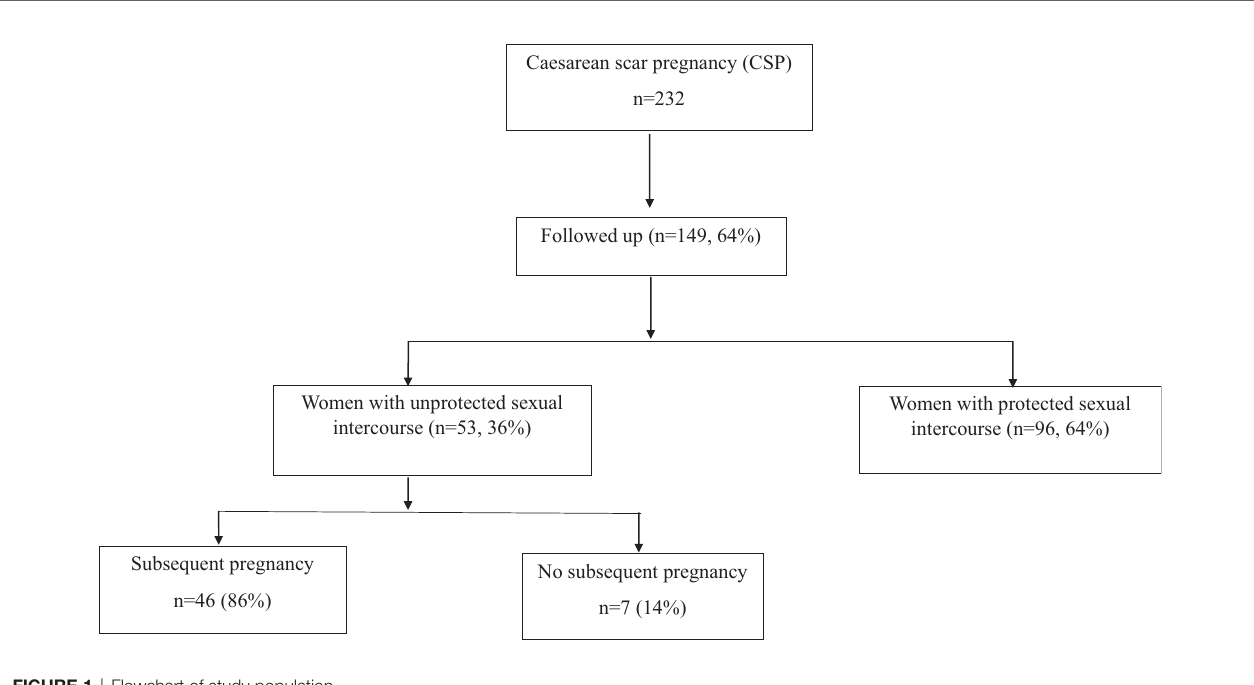
FIGURE 1 | Flowchart of study population.